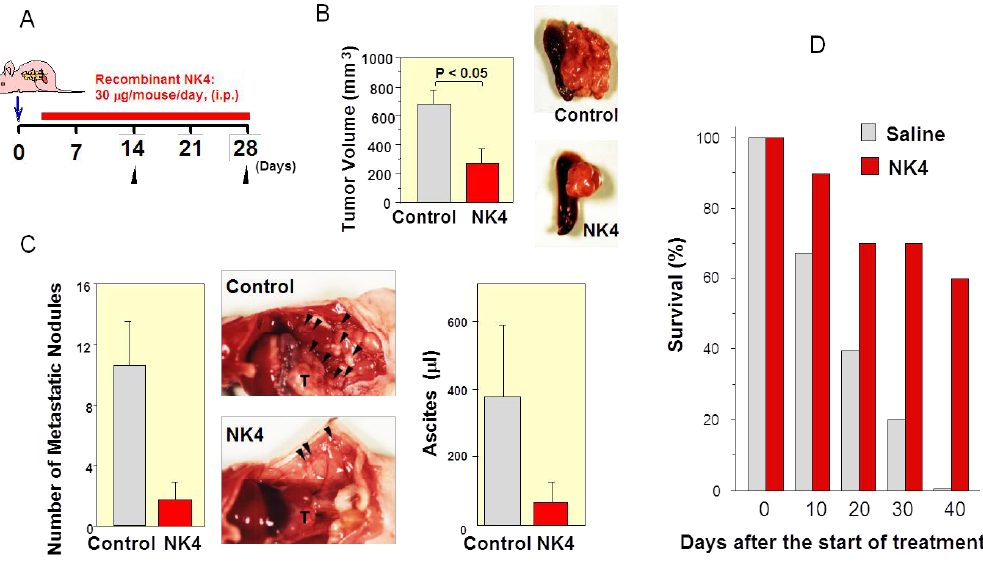
Figure 4. Anti-metastatic effects of NK4 on advanced pancreas cancer in